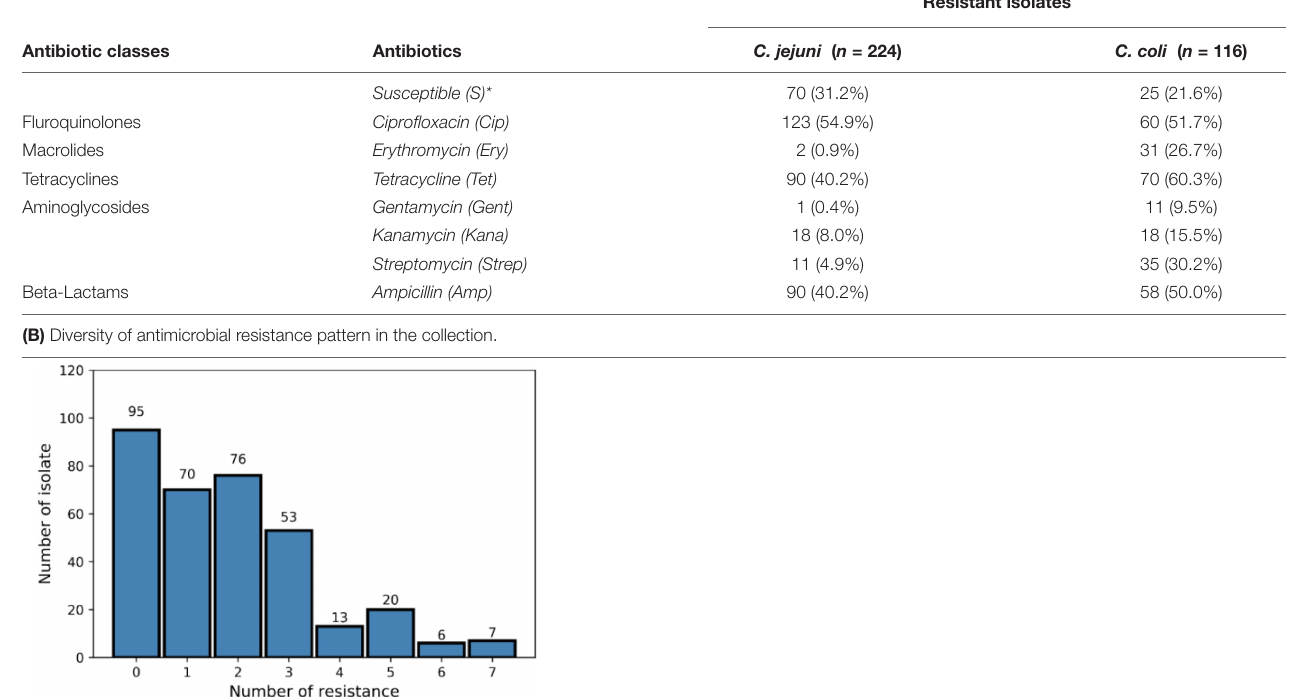
Resistant isolates